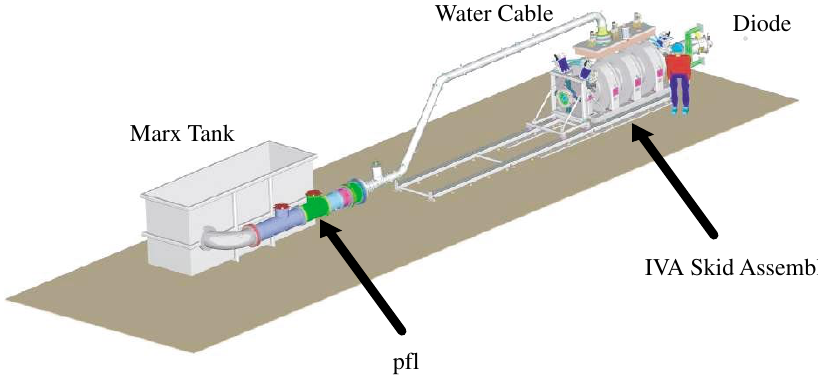
FIG. 36. (Color) Cygnus-I accelerator layout.